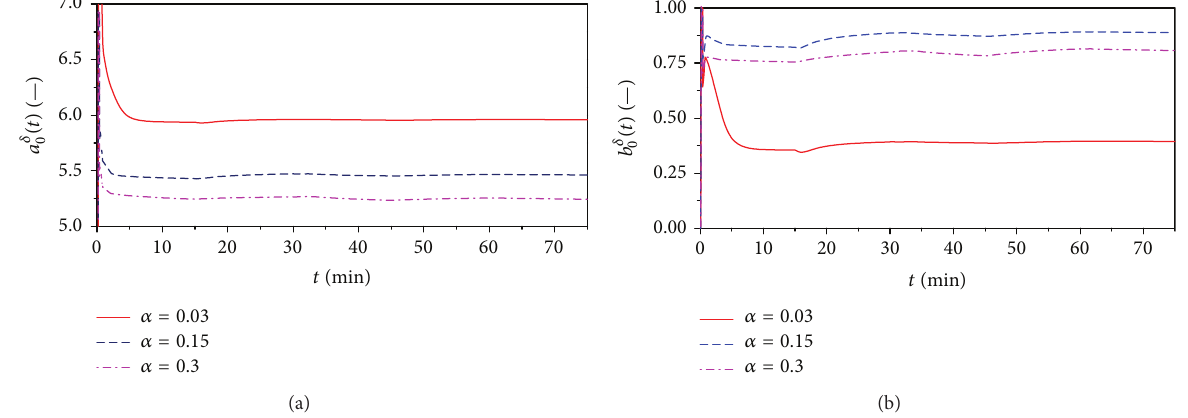
Figure 14: The course of identified parameters 𝑎 𝛿 0 (a) and 𝑏 𝛿 0 (b) for nonlinear adaptive controller.